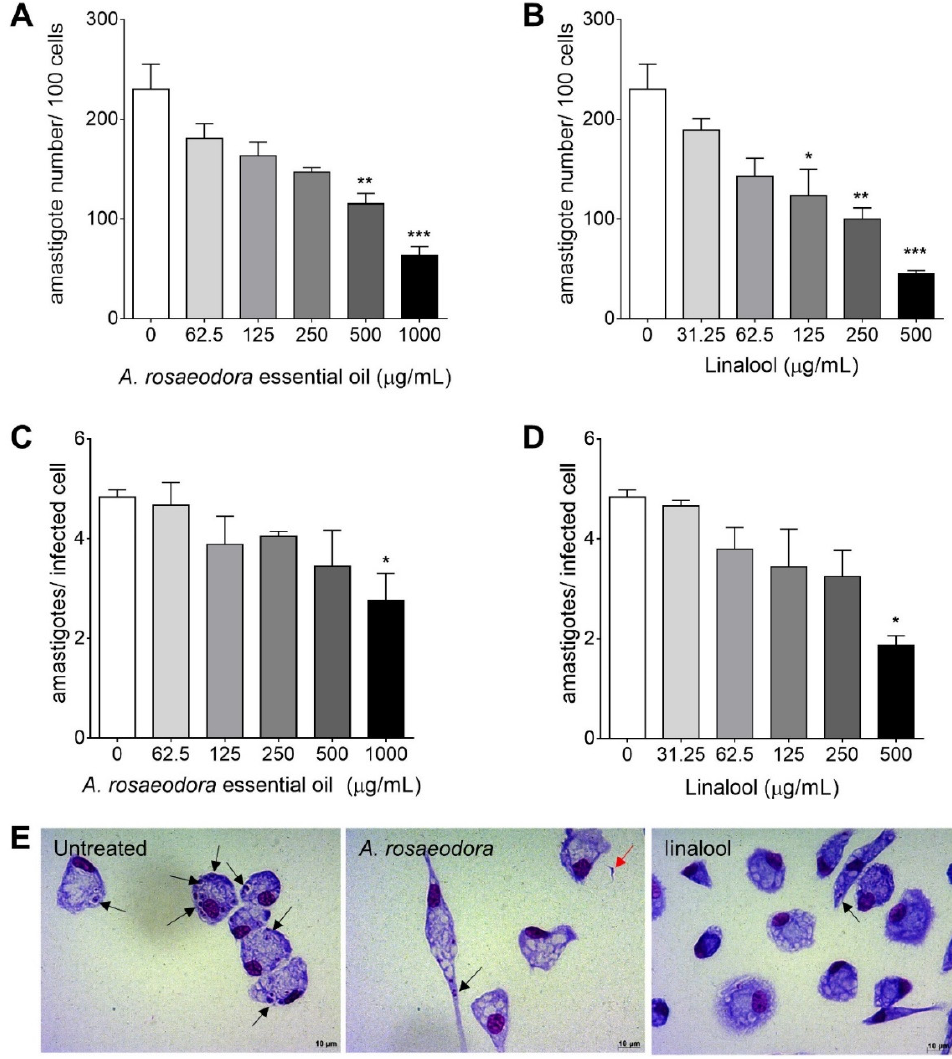
Figure 5. BALB/c peritoneal macrophages infected with Trypanosoma cruzi and treated for 24 h with Aniba rosaeodora essential oil or linalool. ( A – D ) Parameters of infection and ( E ) light microscopy after A. rosaeodora or linalool treatment at 1000 or 500 µg/mL respectively. Intracellular amastigotes inside macrophages (black arrows) and non-internalized parasite (red arrows). The images and data (mean ± standard deviation) represent two independent experiments performed in